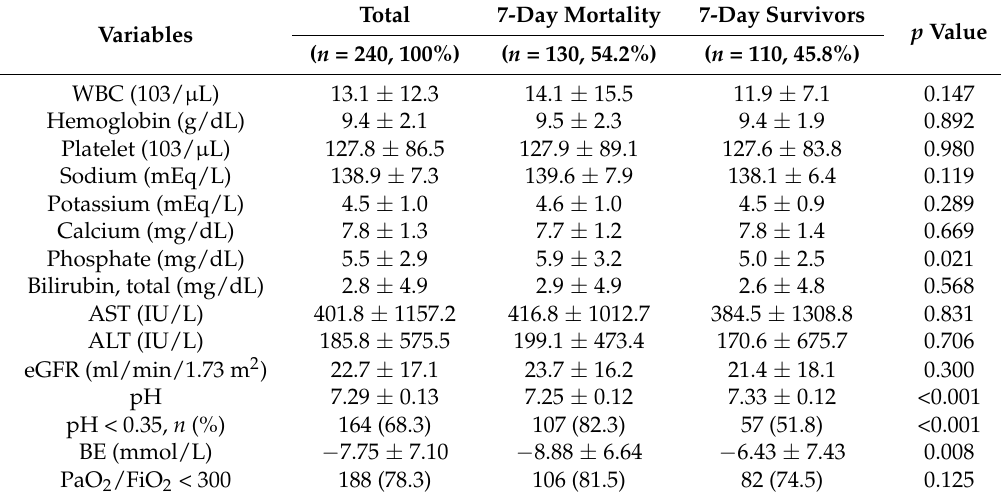
Table 2. Baseline laboratory data of study